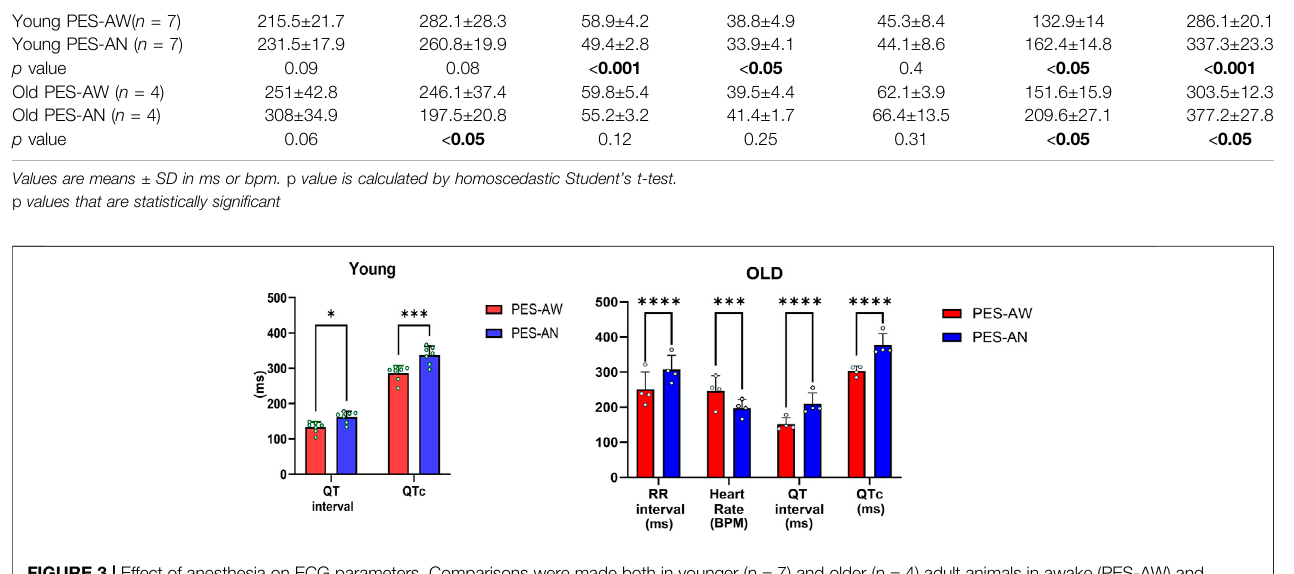
Frontiers in Physiology |